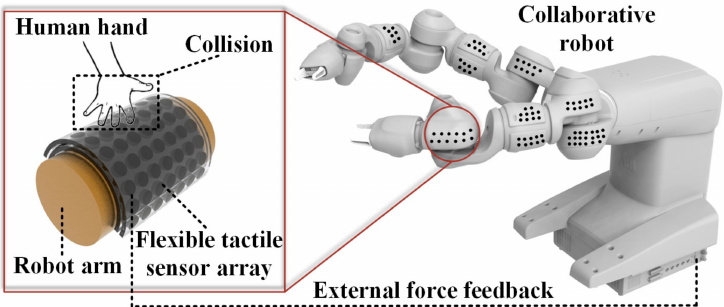
Figure 1. The flexible tactile sensor to endow YuMi robots with the perception of external force